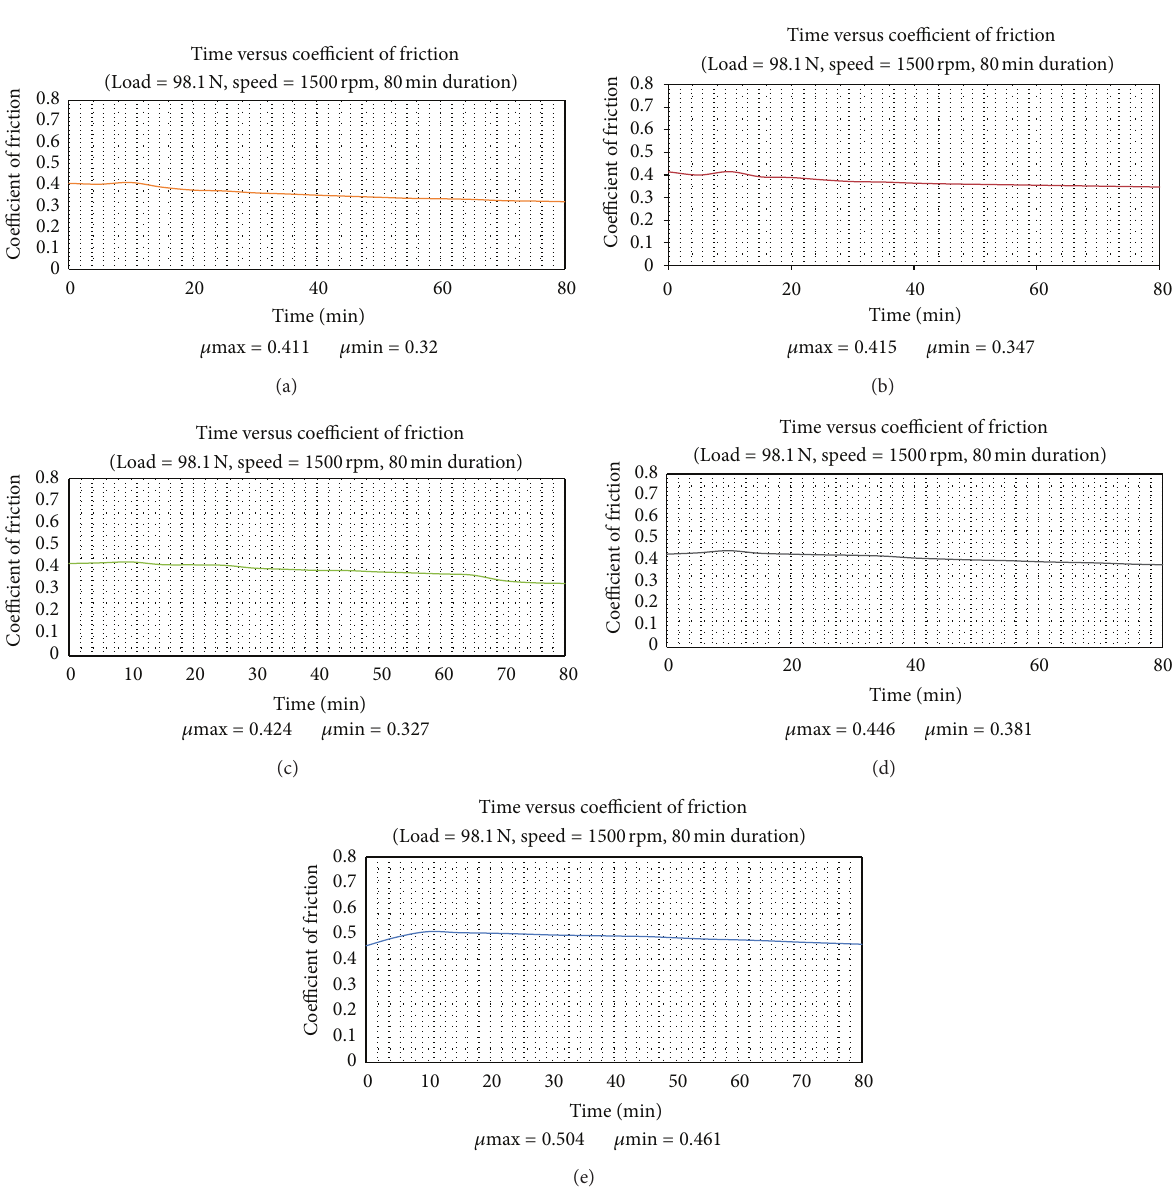
Figure 10: (a) Time versus 𝜇 for Na01. (b) Time versus 𝜇 for Na02. (c) Time versus 𝜇 for Na03. (d) Time versus 𝜇 for Na04. (e) Time versus 𝜇 for